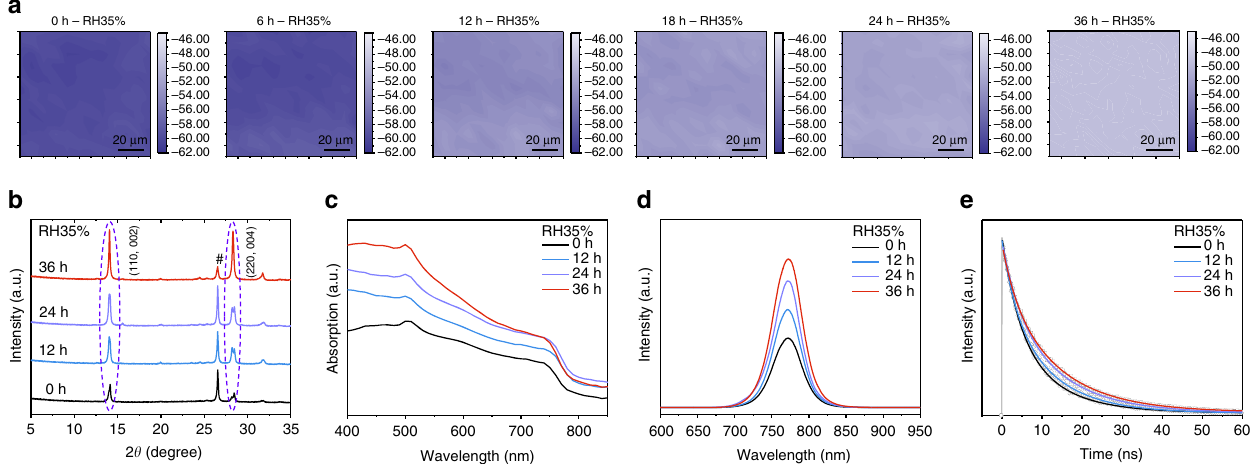
Figure 3 | In situ characterization of intermediate evolution in the scaffolds during ambient exposure. ( a ) In situ FTIR mapping measurement results of intermediate infiltrated in the ZrO 2 layer during ambient exposure (RH35%). The scanning area is 100 m m (cid:4) 100 m m, and the intensity is calculated by the peak area between 2,890 and 3,340cm (cid:3) 1 , which corresponds to the vibration of N–H. ( b ) X-ray diffraction patterns of intermediate infiltrated in TiO 2 / ZrO 2 /Carbon triple layer during ambient exposure (RH35% for 36h). # represents the peak of carbon. The (110)/(002) and (220)/(004) peaks of CH 3 NH 3 PbI 3 are also marked. ( c ) Ultraviolet–visible (UV–vis) spectra of intermediate infiltrated in m-TiO 2 layer during ambient exposure (RH35% for 36h). ( d ) Steady-state PL spectra of intermediate infiltrated in the ZrO 2 layer during ambient exposure (RH35% for 36h). ( e ) Time-resolved PL spectra of intermediate infiltrated in the ZrO 2 layer during ambient exposure (RH35% for